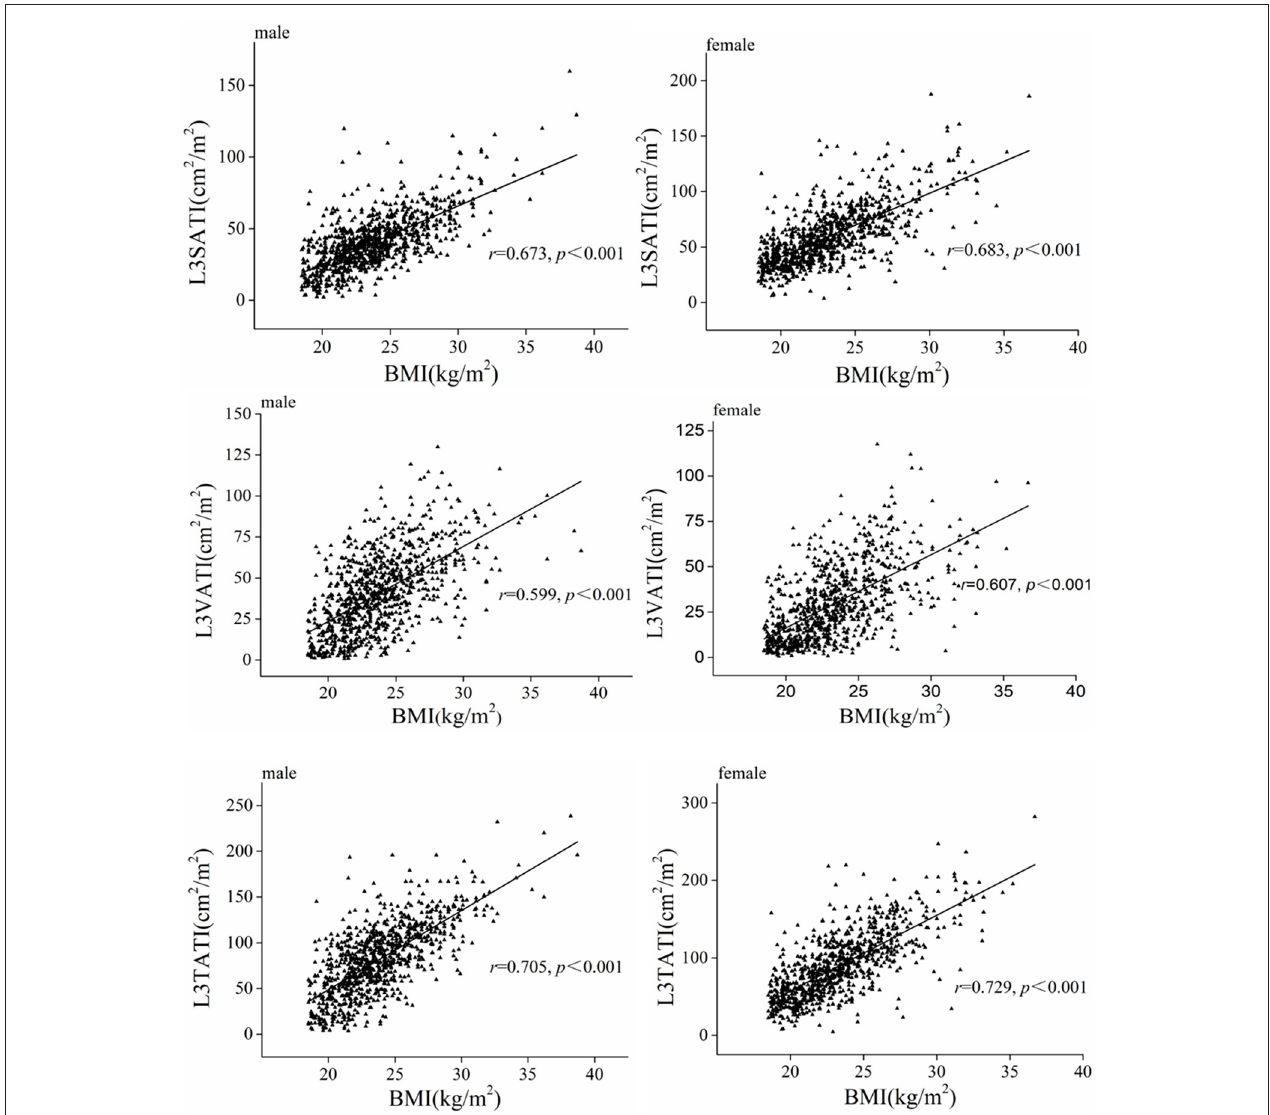
FIGURE 3 | Scatter graph depicting correlations between adipose tissue index (VATI, SATI, and TATI) and BMI classified according to